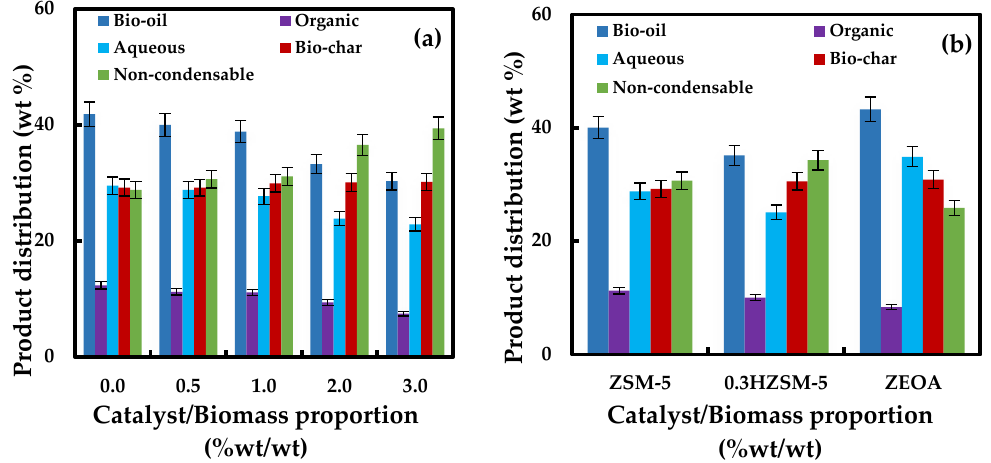
Figure 4. Pyrolysis products distribution ( a ) Effect of ZSM-5 loading; ( b ) impact of 0.3HZSM-5 and ZEOA at 0.5 wt % loading compared to ZSM-5.